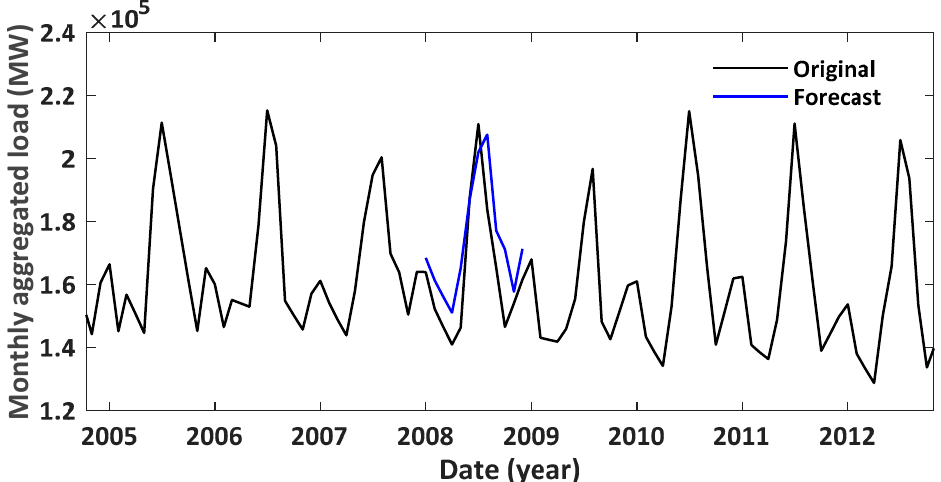
Figure 12. Directional accuracy of multiplicative error model (MEM) during great recession of 2008.